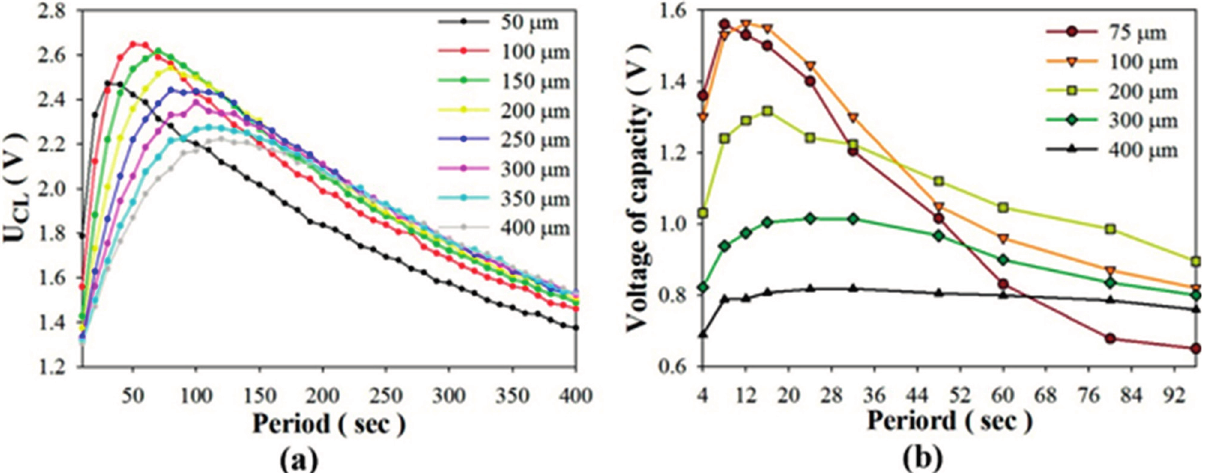
Figure 11. Relationships between the stored voltage and various periods when using PZT cells with various thicknesses as determined in the simulated calculation ( a ); and the experiment ( b